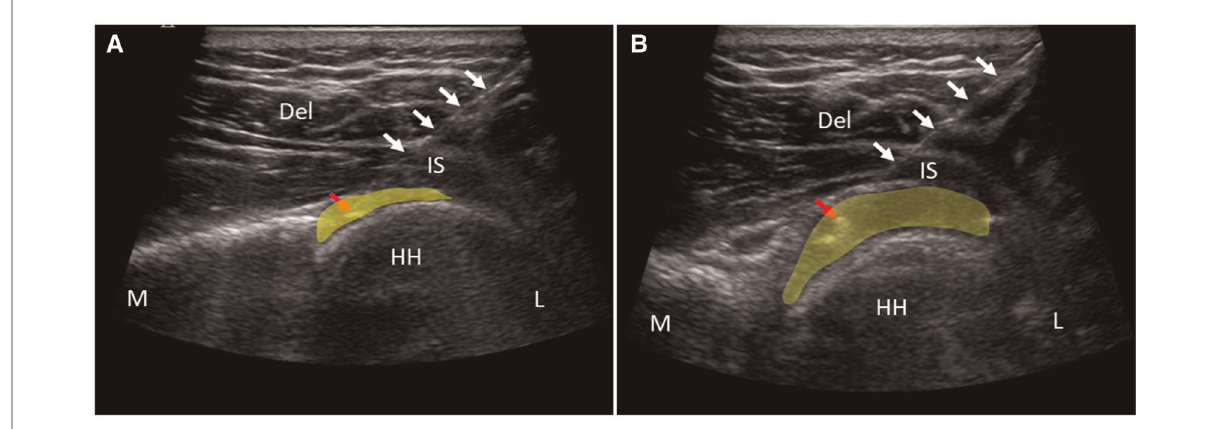
FIGURE 1 US-guided shoulder joint cavity injection and before ( A ) and after ( B ) distension treatment. Del, deltoid muscle; HH, humeral head; IS, infraspinatus tendon; L, lateral; M, medial. White arrows indicate the injection needle. Red arrow points at the tip of injection needle. The highlighted yellow area indicates the shoulder joint